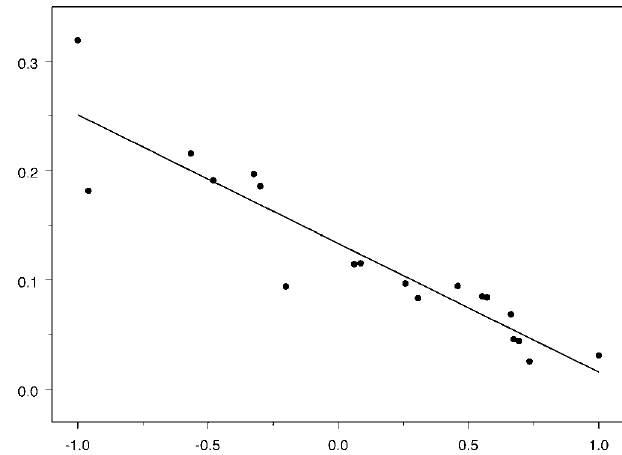
Figure 3. Selection Differential on Birthweight against Environmental Quality Each point represents the values measured in 1 y, and the solid line shows the least-squares linear regression of selection differential (S) on environmental quality (E). The strength of selection acting on birth- weight declines as the environmental quality improves. DOI: 10.1371/journal.pbio.0040216.g003